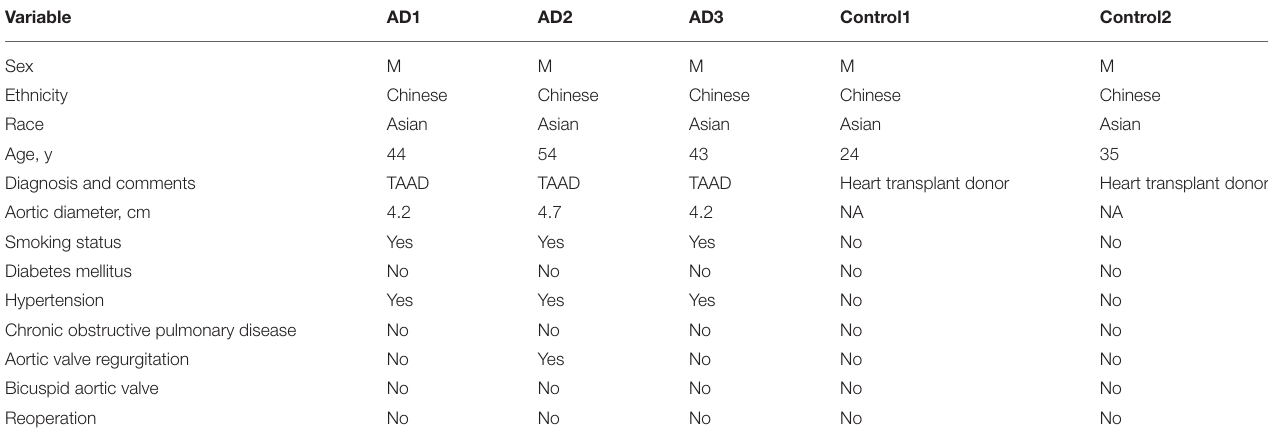
TABLE 1 | Patient Information for Ascending Aortic Samples ( n = 5).